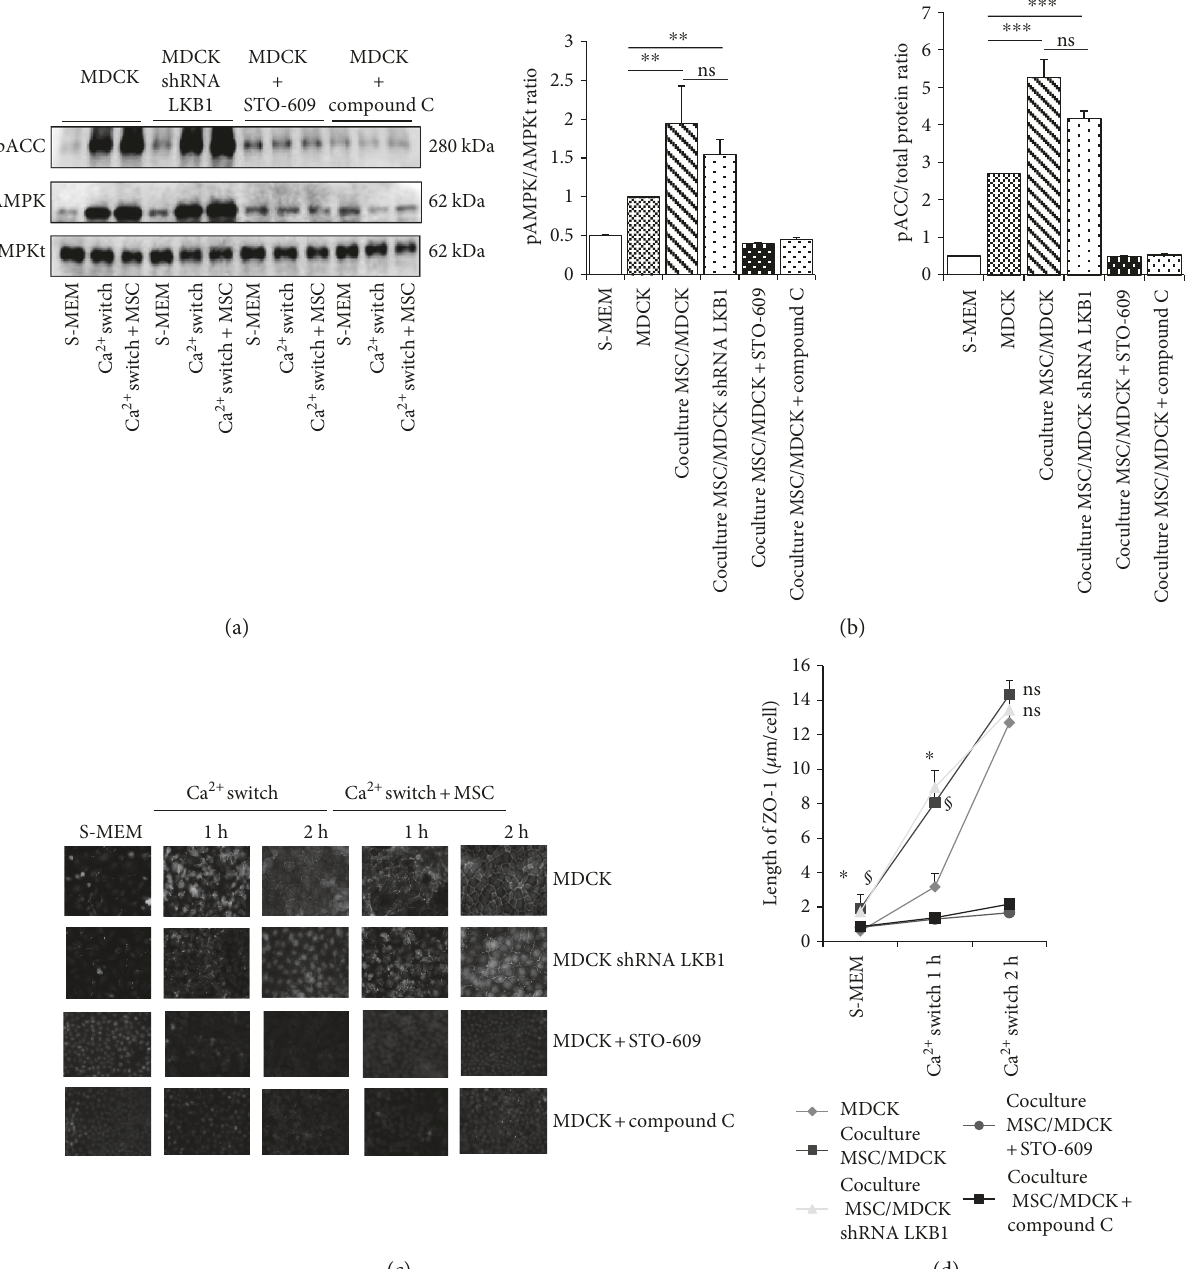
Figure 2: Impact of mesenchymal stromal cells (MSC) on AMPK activation and ZO-1 relocation following a Ca 2+ switch in MDCK cells. Representative immunoblotting (a) and quanti fi cations (b) of phospho-acetyl-Coa carboxylase (pACC), phospho-AMP-activated protein kinase (pAMPK), and total AMPK (AMPKt) in low Ca 2+ conditions (S-MEM) and following Ca 2+ switch using MDCK cells or LKB1- shRNA MDCK cells, with versus without MSC. Compounds STO-609 and C were used as CaMKK and AMPK inhibitors, respectively. Quanti fi cations of immunoreactive signals were performed by stain-free method after normalization to total protein content of each lane. Data are presented as mean ± SD; ns: not signi fi cant, ∗∗ p ≤ 0 01 , ∗∗∗ p ≤ 0 001 . Representative immuno fl uorescence (c) and quanti fi cations (d) of ZO-1 deposits at increasing time points following Ca 2+ switch in similar conditions as in (a) and (b) (scale bar: 16 μ m). MSC/ MDCK (i.e., MDCK ( § p ≤ 0 01 ) or MDCK LKB1-shRNA ( ∗ p ≤ 0 01 )) cocultures show signi fi cantly increased ZO-1 deposits at 1-hour post Ca 2+ switch in comparison to MDCK alone. At 2 hours post Ca 2+ switch, no signi fi cant (ns) di ff erence in ZO-1 lengths is observed between MDCK and MSC/MDCKs. Data are presented as mean ±